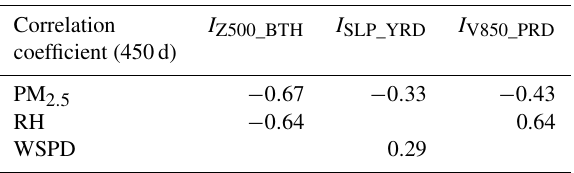
Table 2. Correlation of circulation-based indices defined in this study (Eqs. 3–5) with daily PM 2 . 5 concentrations over BTH, YRD and PRD, and with the most important regional meteorological vari- able in each region during DJF 2013–2017. All correlations are sig- nificant at the 99% confidence